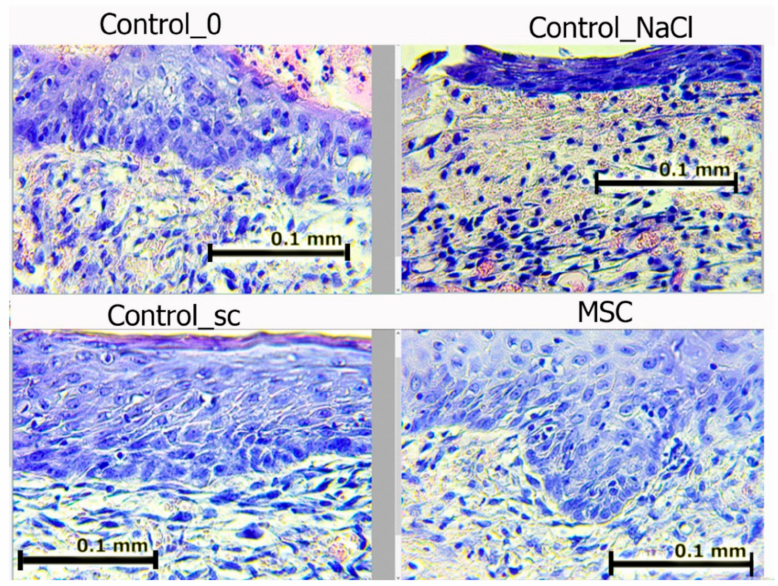
Figure 8. Wound edges in different groups on day 7. Hematoxylin and eosin staining (400 × ). The scale bar is 0.1 mm.